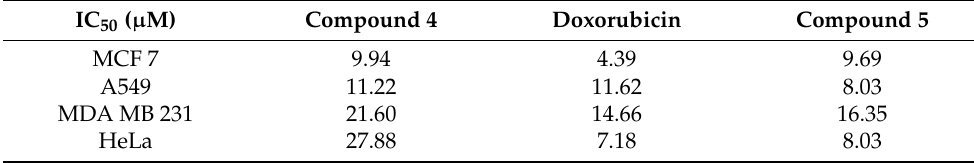
Table 1. IC 50 values of compounds 4 and 5 against four cancer cell